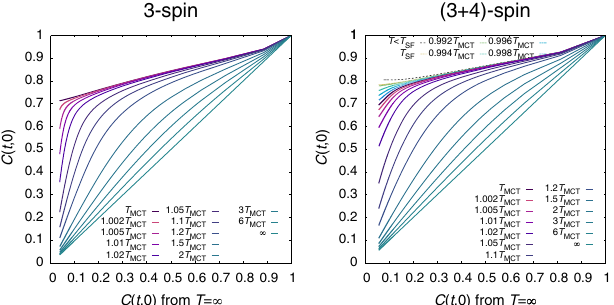
FIG. 32. Same data for the decay of the correlation with the initial configuration C ð t; 0 Þ as in Fig. 31, but here instead of the time, we use the C ð t; 0 Þ measured starting from a random configuration ( T ¼ ∞ ) on the x axis. As in Fig. 31, the data for the three-spin model extrapolate to zero, while the data for the ( 3 þ 4 )-spin model seem much more compatible with a nonzero limit q 12 when the temperature gets close to T MCT